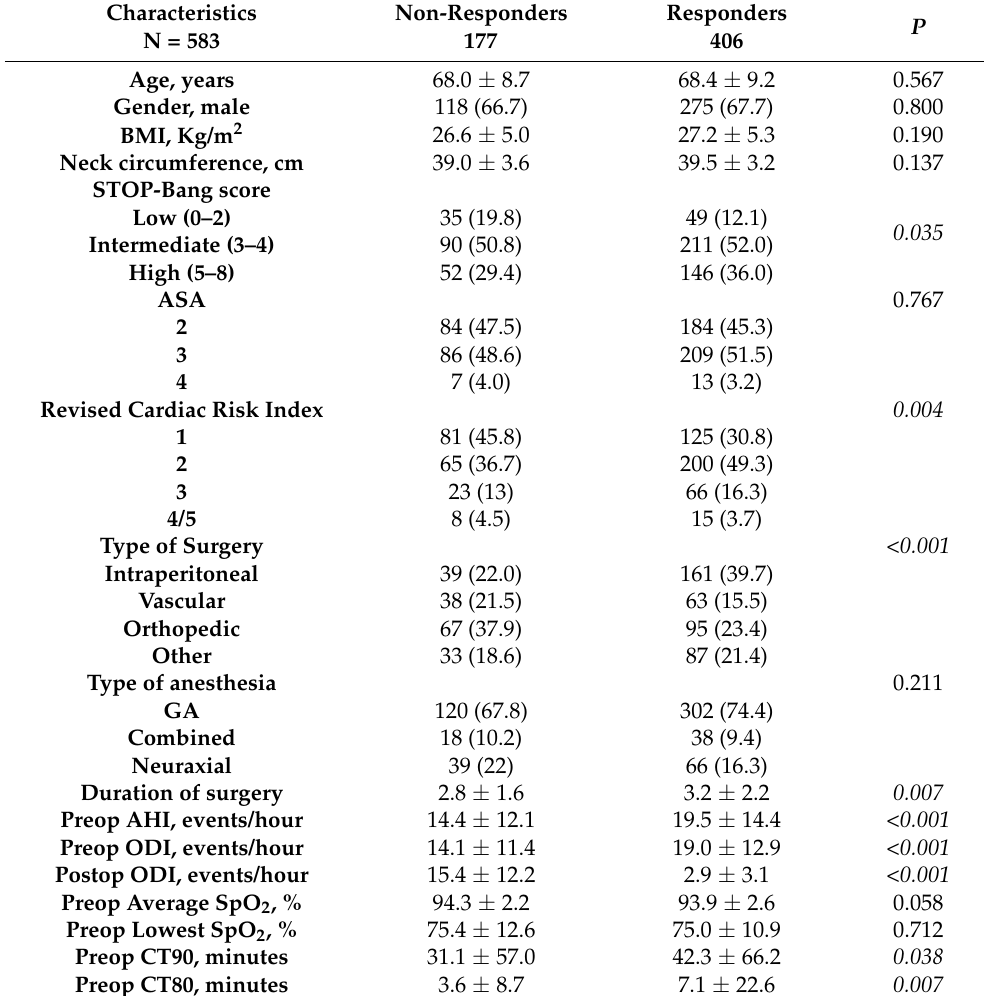
Table 3. The clinical characteristics of patients with unrecognized OSA based on responsiveness to postoperative oxygen